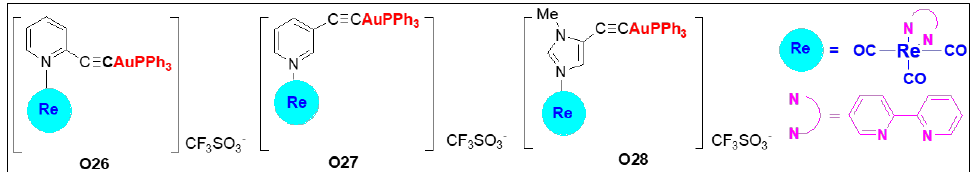
Figure 16. Heterometallic Re(I)/Au(I) complexes ( O26 – O28 ) with potential for cell imaging and cancer therapy.